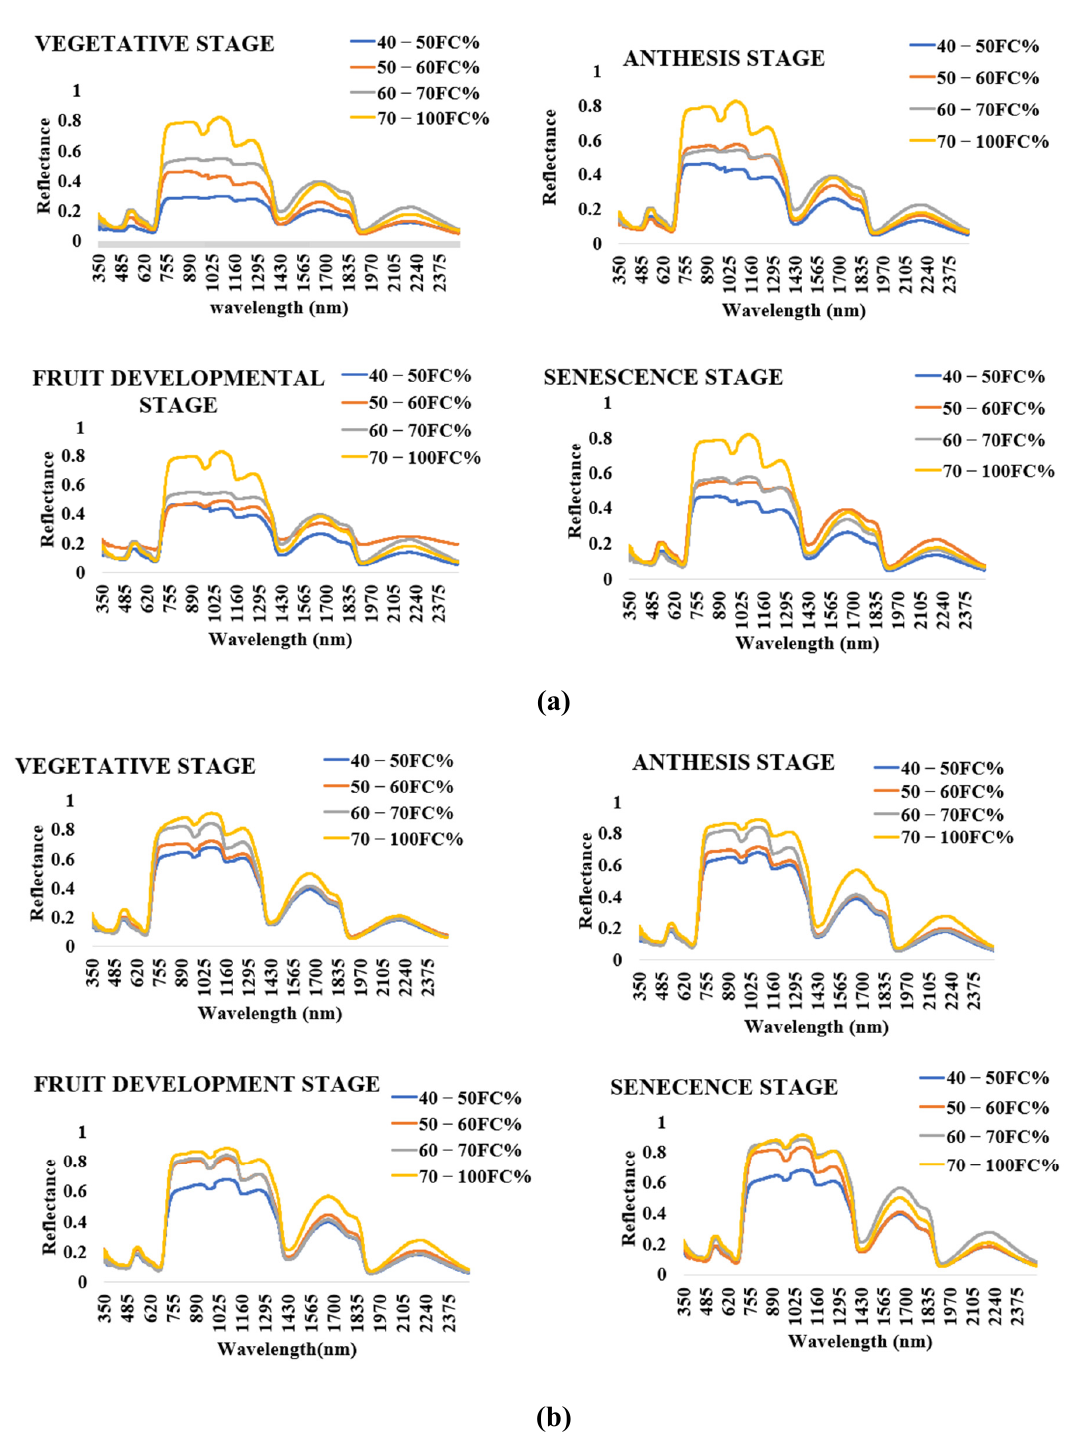
Figure 4. Spectral signatures of the tomato plant leaves at different growth stages for different % FC level for silty loam soil and sandy loam soil: ( a ) spectral signatures of the tomato plant leaves at different growth stages for different % FC for silty loam soil; ( b ) spectral signatures of the tomato plant leave at different growth stages for different % FC level for sandy loam